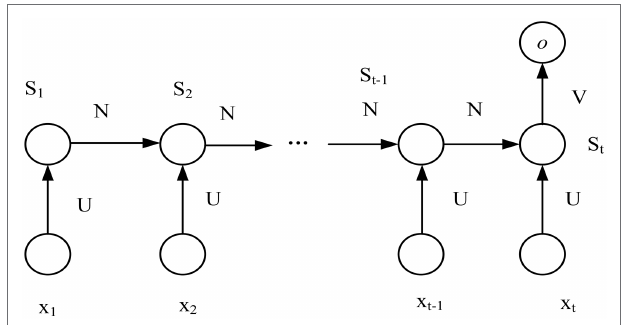
FIGURE 4 | RNN model with multiple inputs and single output.